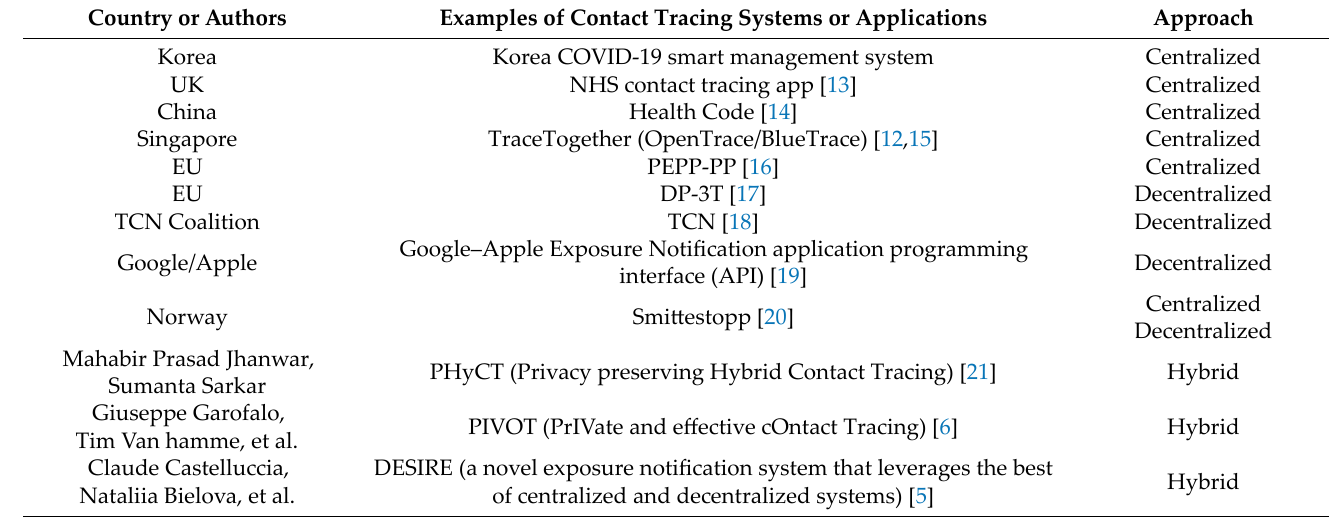
Table 2. The examples of contact tracing systems/applications by